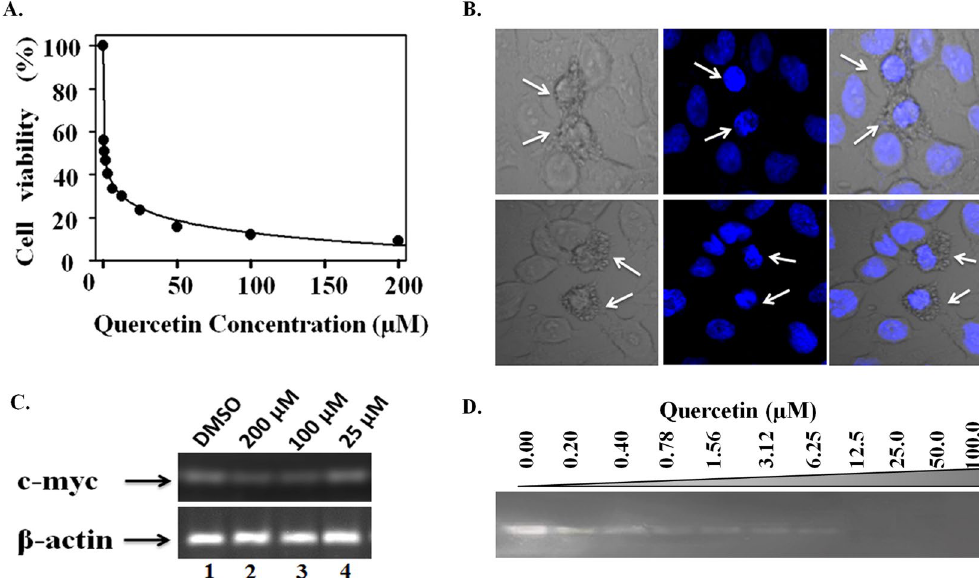
Figure 10. Effect of Quercetin on HeLa cell lines. ( A ) HeLa cells were exposed to Quercetin at different concentration as indicated. Cell viability was measured by MTT assay after 48 h. ( B ) Morphological changes observed under confocal microscope for Quercetin (100 µ M for 4 h) treated HeLa cells followed by DAPI staining (The arrow indicates the apoptotic cells). ( C ) Representative semi-quantitative RT-PCR analysis. β -actin was used as internal control. (Full-length gel image is available at Supplementary Fig. S13). ( D